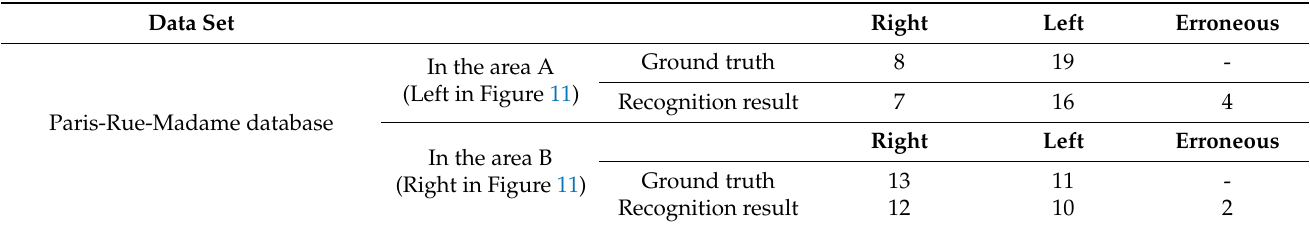
Table 3. The results of recognizing actual vehicles on Pari-Rue-Madame database. Data